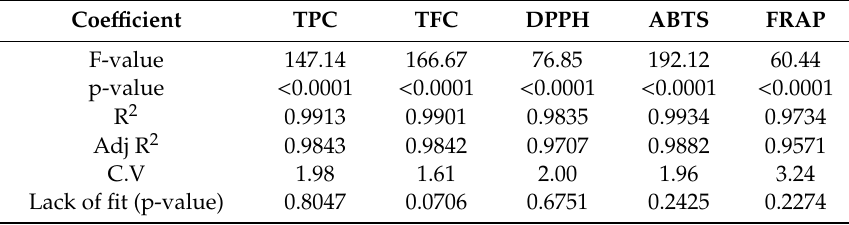
Table 3. Statistical parameters of the five model